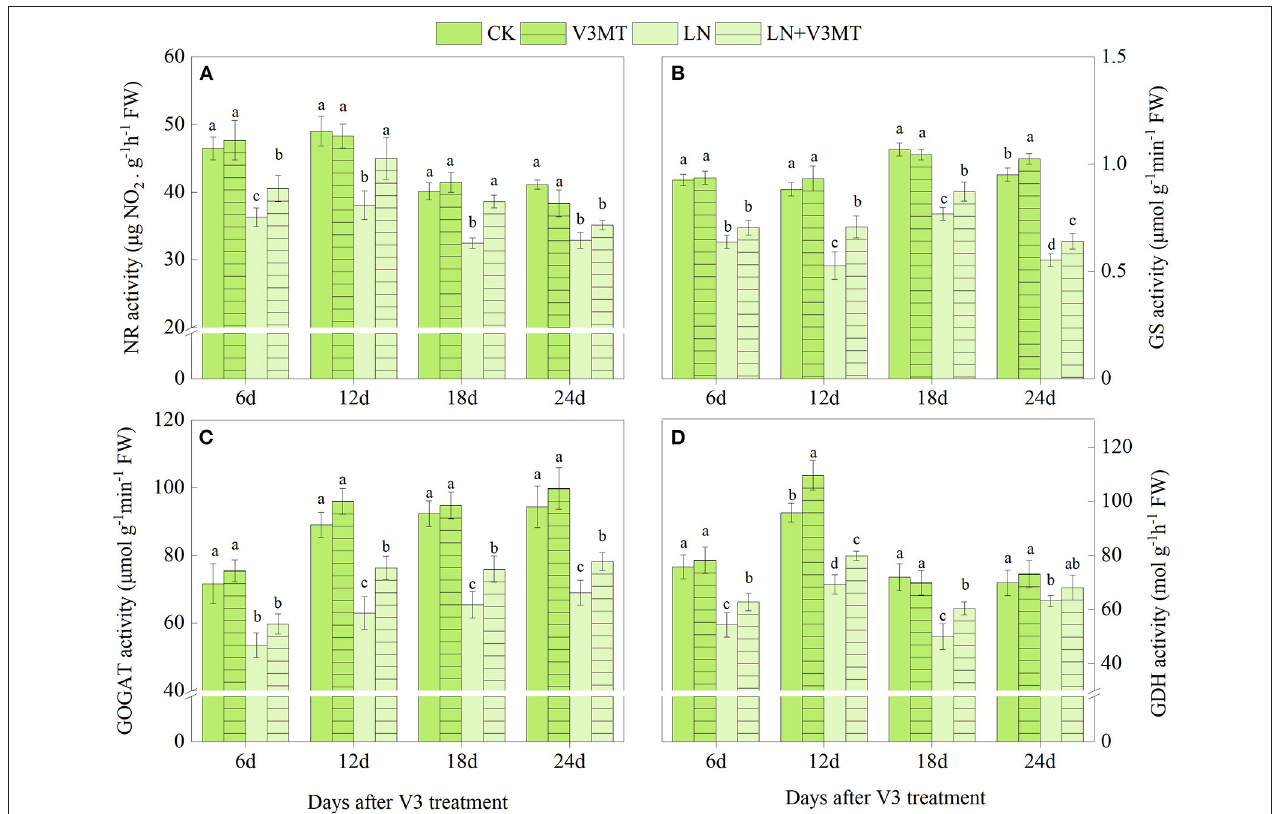
FIGURE 1 | The effect of spraying melatonin at V3 stage on the activities of nitrate reductase (NR, A ), glutamine synthetase (GS, B ), glutamate synthase (GOGAT, C ), and glutamate dehydrogenase (GDH, D ) in plant leaves under two N levels. CK, control nitrogen; V3MT, melatonin application at V3 stage under control nitrogen level; LN, low nitrogen; LN + V3MT, melatonin application at V3 stage under low nitrogen level. The values were presented as mean ± SE ( n = 3). Different letters in one measuring group indicate statistically significant differences when P ≤